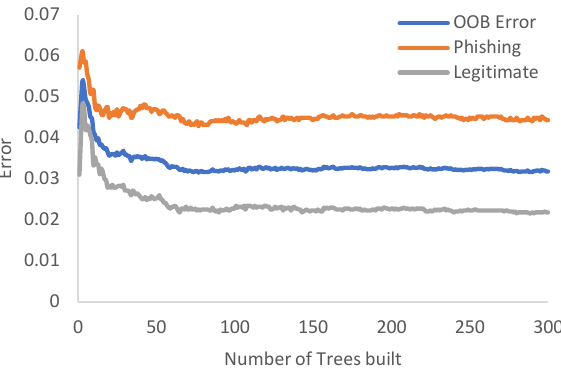
Figure 2. Random Forest Error Values In the above figure 2, the X-Axis represents the number of trees built in Random Forest. The green plot on the Y- Axis represents the OOB error for different number of trees, the black plot represents the root-mean squared error in class 1 for different number of trees and the red plot represents the root-mean squared error in class -1for different number of trees. All the errors stop decreasing till the number of trees reaches to